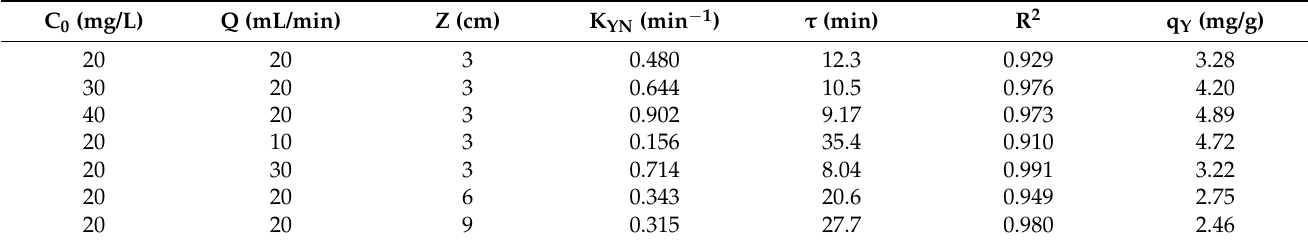
Figure 7. Yoon-Nelson model fitting of F − adsorption by FBC varying ( a ) F − concentration; ( b ) flow rate; ( c ) bed height. Table 3. Calculated fixed-bed parameters using the Yoon-Nelson model.